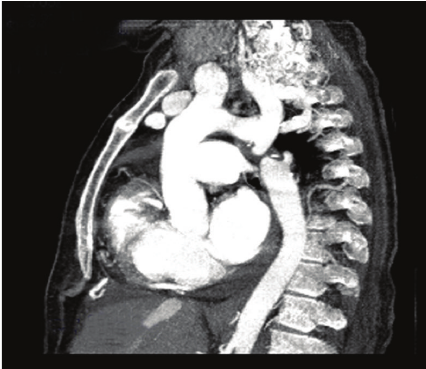
Figure 1: CT angiography showing type A interrupted aortic arch distal to the left subclavian artery.